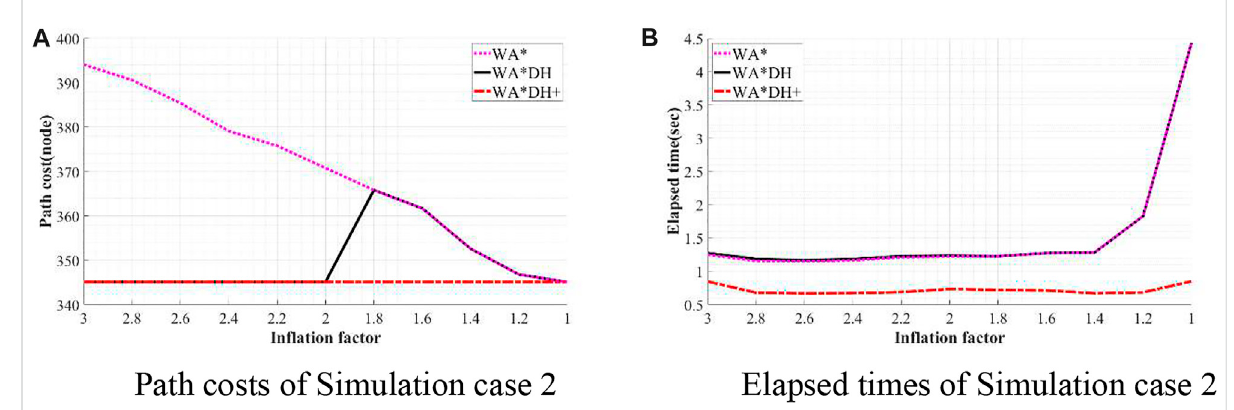
FIGURE 12 Result of simulation case 2. (A) Path costs of simulation case 2. (B) Elapsed times of simulation case 2.